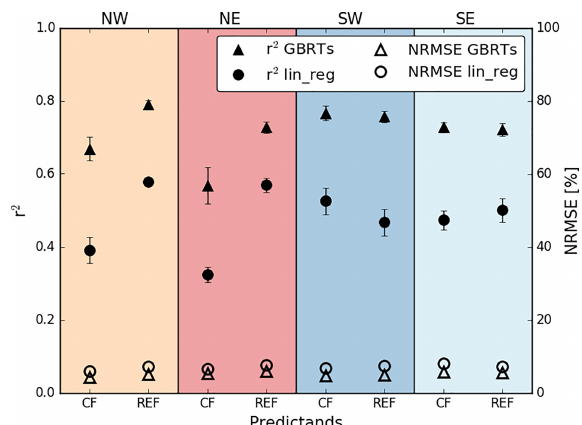
Figure 1. The overall mean quality of the GBRT models (triangles) is compared to a simple least squares linear regression (circles) for CF and REF in the four subregions NW, NE, SW and SE during JAS. The models are evaluated based on the coefficient of determi- nation ( r 2 ) and normalized root mean squared error (NRMSE) be- tween predicted and observed CF (REF). The error bars range from the minimum to maximum r 2 obtained from 10 different models using randomly chosen training